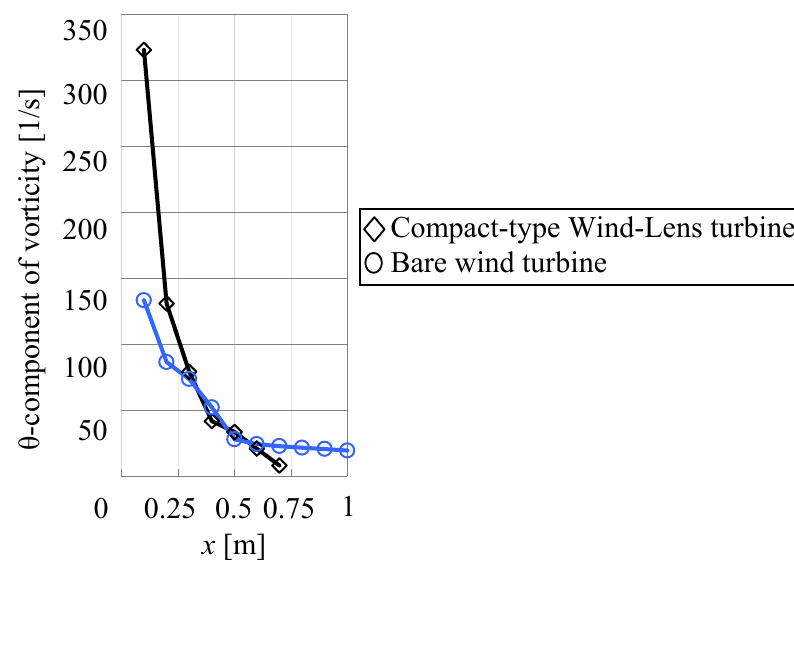
Figure 16. Comparison of the θ -component of the vorticity between the compact-type Wind-Lens turbine and the bare wind